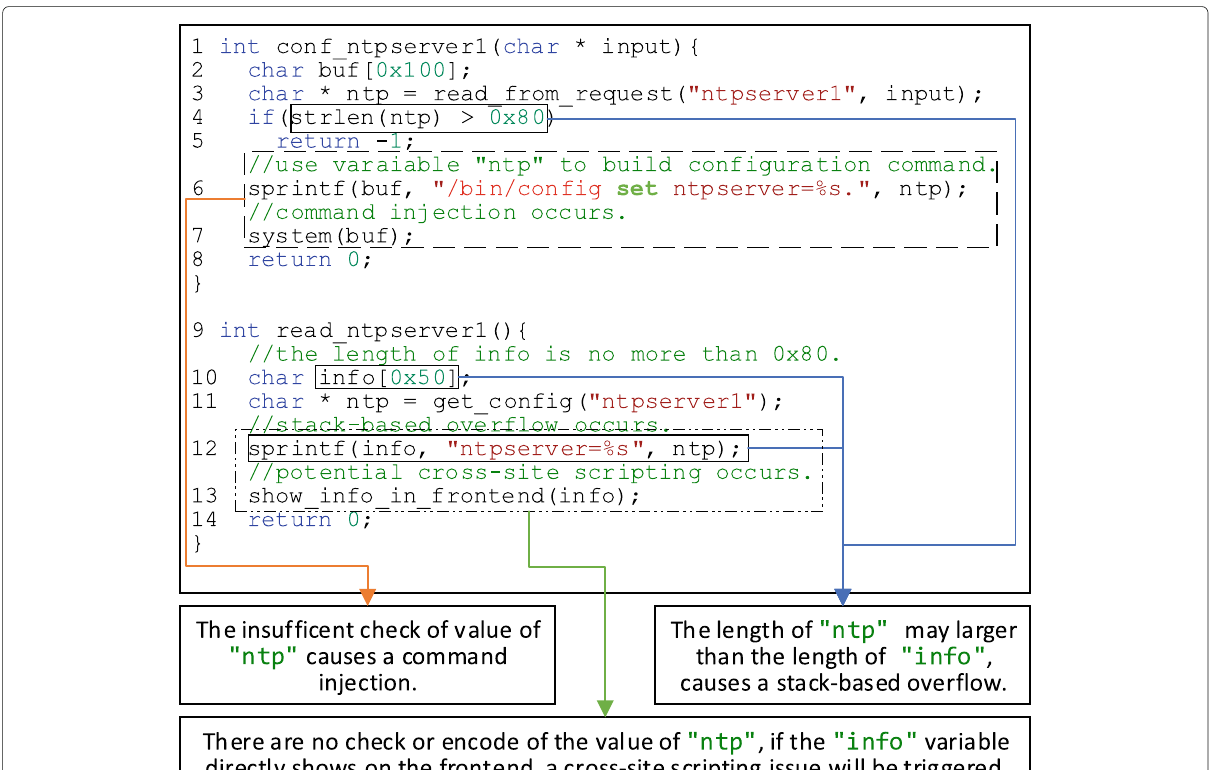
Fig. 3 Backend Handlers Code Snippet of READ and CONF Operation for NTP configuration